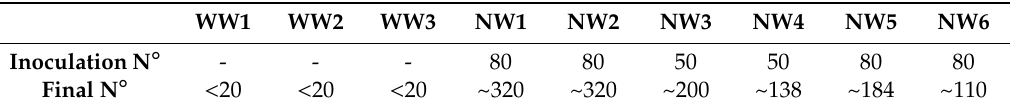
Table 1. Nematode population growth. Inoculum density (Inoculation N°) expressed as the number of dagger-nematodes introduced in each pot at the start of the experiment. The without wounding (WW) control plants did not receive the inoculum (-). An inoculum of 80 or 50 nematodes was dispensed to the nematode wounded (NW) grapevines. After 3 months, at the end of the experiment, the numbers of nematodes (Final N°) were analyzed. Three control (WW1-WW3) and six inoculated (NW1-NW6) plants were analyzed. WW1 WW2 WW3